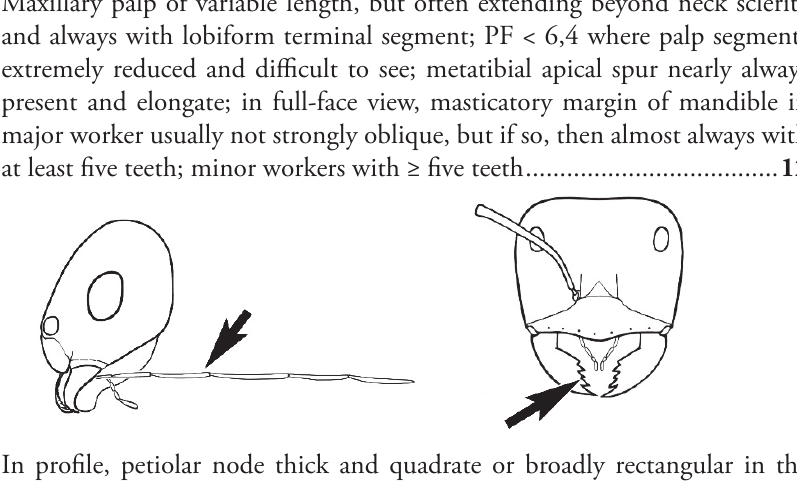
9 In profile, petiolar node thick and quadrate or broadly rectangular in the minor worker; major worker hairy and rather matt in appearance ............. 10 – In profile, petiolar node thickly squamiform in the minor worker; known major worker ( M . chrysus ) smooth and glossy in appearance .....................